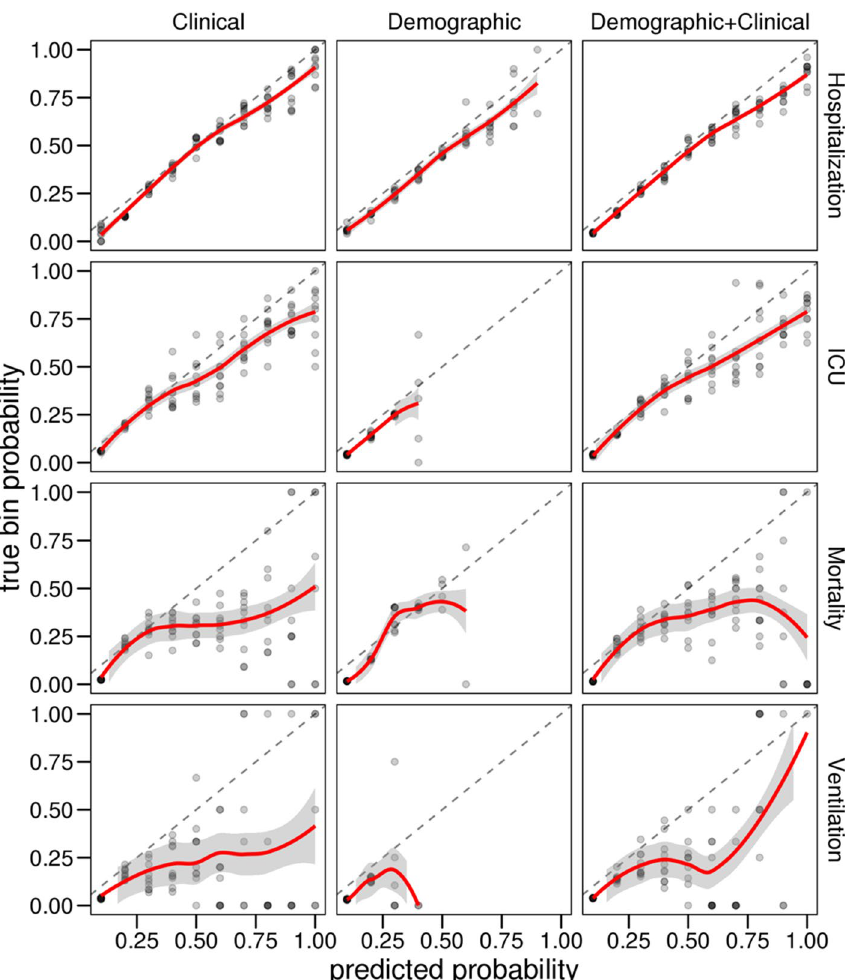
Figure 3. The diagnostic reliability diagrams (calibration